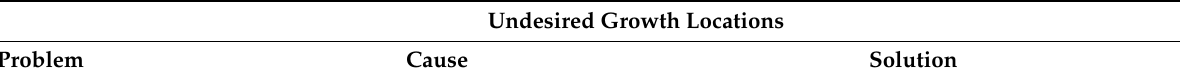
Table 8. Listed are the most frequently occurring challenges concerning undesired growth locations with their respective cause and a suggested